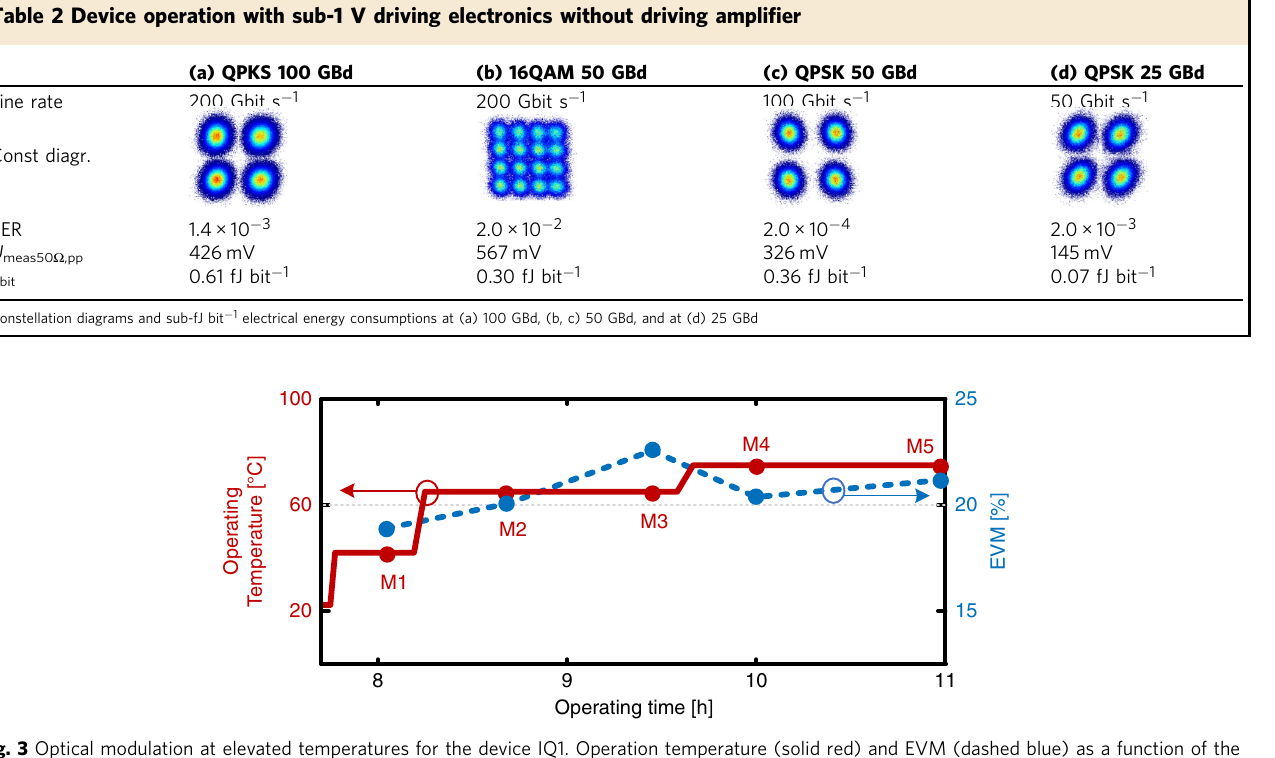
Fig. 3 Optical modulation at elevated temperatures for the device IQ1. Operation temperature (solid red) and EVM (dashed blue) as a function of the operating time. The EVM remains nearly constant and stays around 20% for all temperatures. All measurements at 50 GBd QPSK. More information